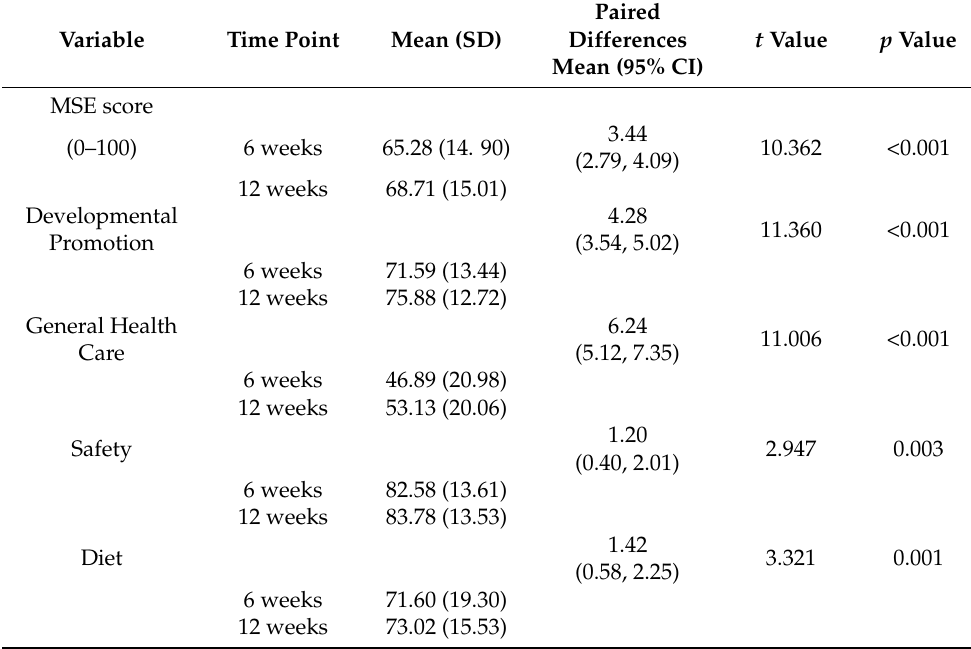
Table 4. Comparison of the mean scores of SICS and its four dimensions at 6 and 12 weeks postpartum ( n =